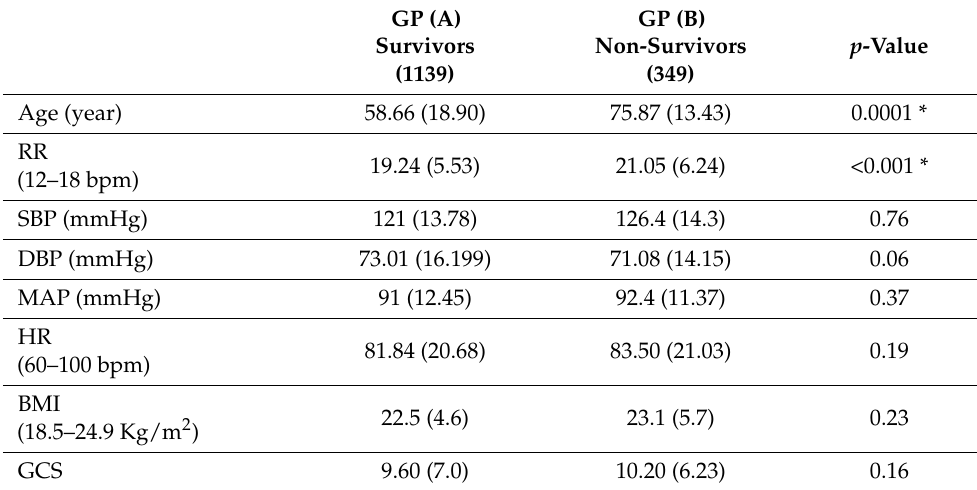
Table 1. Basic Characteristics of the Study